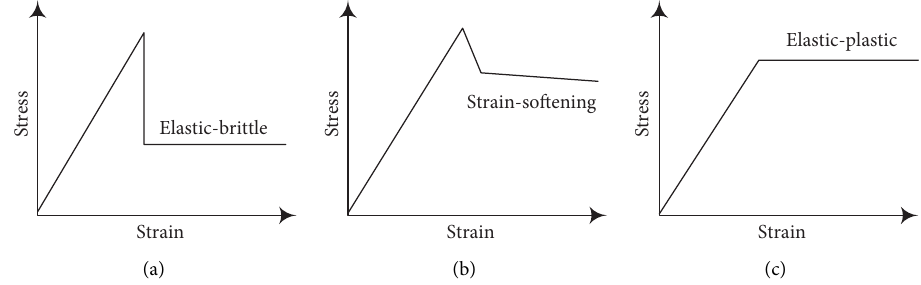
Figure 13: Expected stress-strain behavior of the rockmass with different qualities (Hoek et al. [6]).